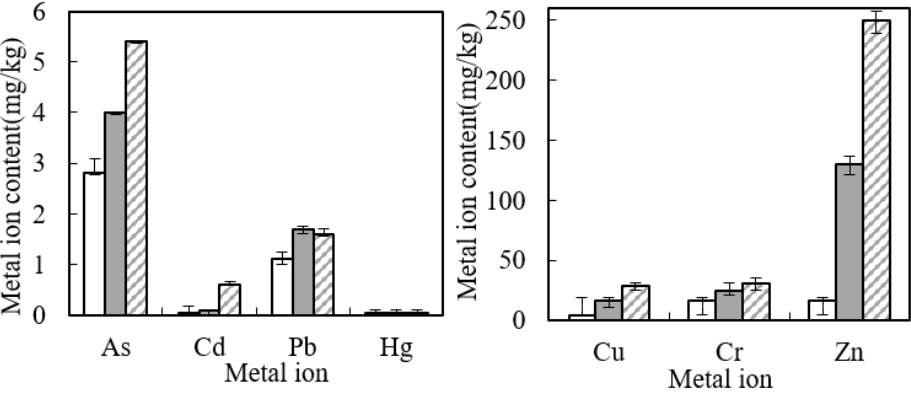
Figure 2. Heavy metals bring-in with the unconventional water for irrigation. mg/kg. The proportion of heavy metals take-away and bring-in in the black soil depth of 0 to 90 cm was shown in Table 6, Figures 3 and 4. As had the highest take-away proportion of 0.88~0.96%, while Cr has the lowest, ranging from 0.064~0.092%. Zn accumulated the highest bring-in proportion of 0.09~0.43%, and Pb accounted for the lowest bring-in proportion, 0.0061~0.013%. This showed that both the bring-in and take-away for heavy